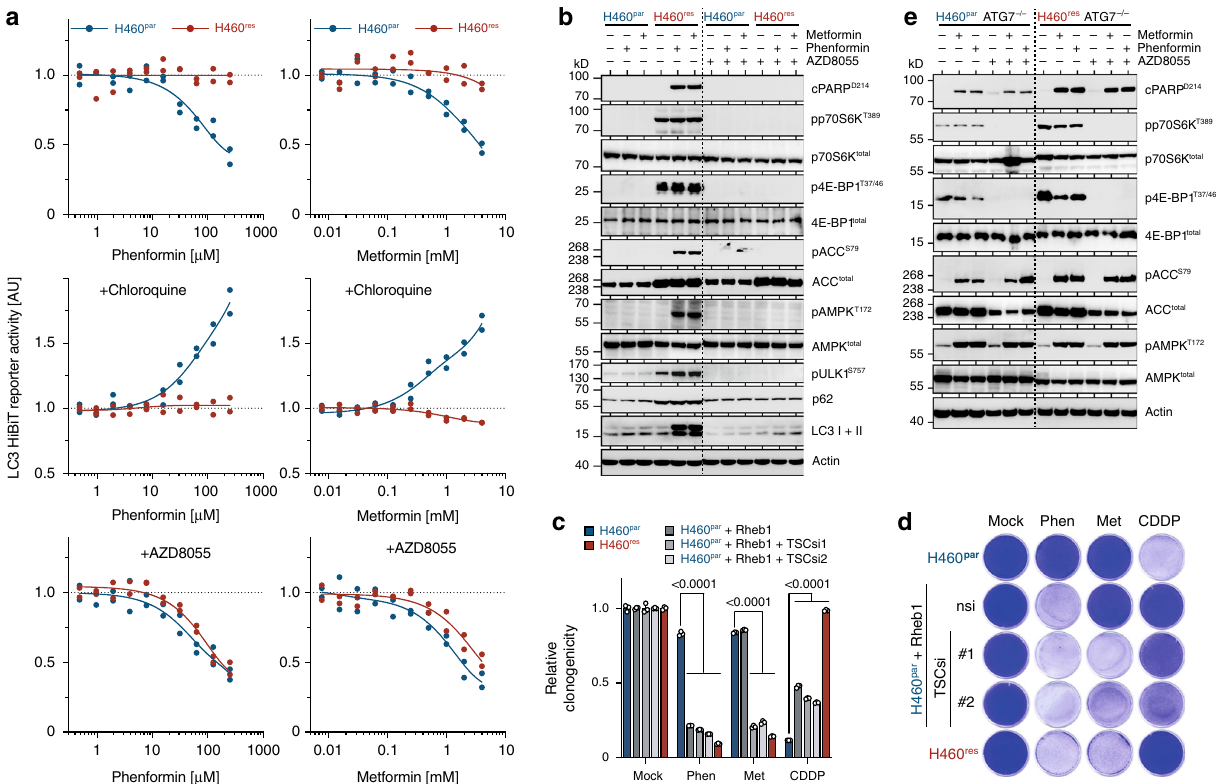
Fig. 5 mTOR-mediated metabolic vulnerability extends to biguanides. a Autophagic fl ux analysis. LC3-HiBiT-expressing H460 par or H460 res cells were pre-treated as indicated with chloroquine and AZD8055 for 48 hours and then treated with increasing doses of Metformin (Met) or Phenformin (Phen) for 6 hours. Shown is LC3-HiBiT reporter activity measured as luminescence normalized to untreated of n = 2 replicates. b Western blot. H460 cells were pre- treated with AZD8055 for 72 hours as indicated before adding Met/Phen for 6 hours. c , d Clonogenic growth of H460 cells expressing Flag-Rheb1 and subsequently transfected with siRNAs targeting TSC were treated with Met, Phen or CDDP. c Quanti fi cation shown as mean ± SD, n = 3, two-way ANOVA with Tukey ’ s multiple comparisons test. d Representative images. e CDDP-sensitive, autophagy-de fi cient H460 par ATG7 – / – cells (clone c2.12 from Fig. 4) were made CDDP-resistant by dose escalation yielding H460 res ATG7 – / – cells. Western blot of cells treated with Met/Phen ± AZD8055 for 3